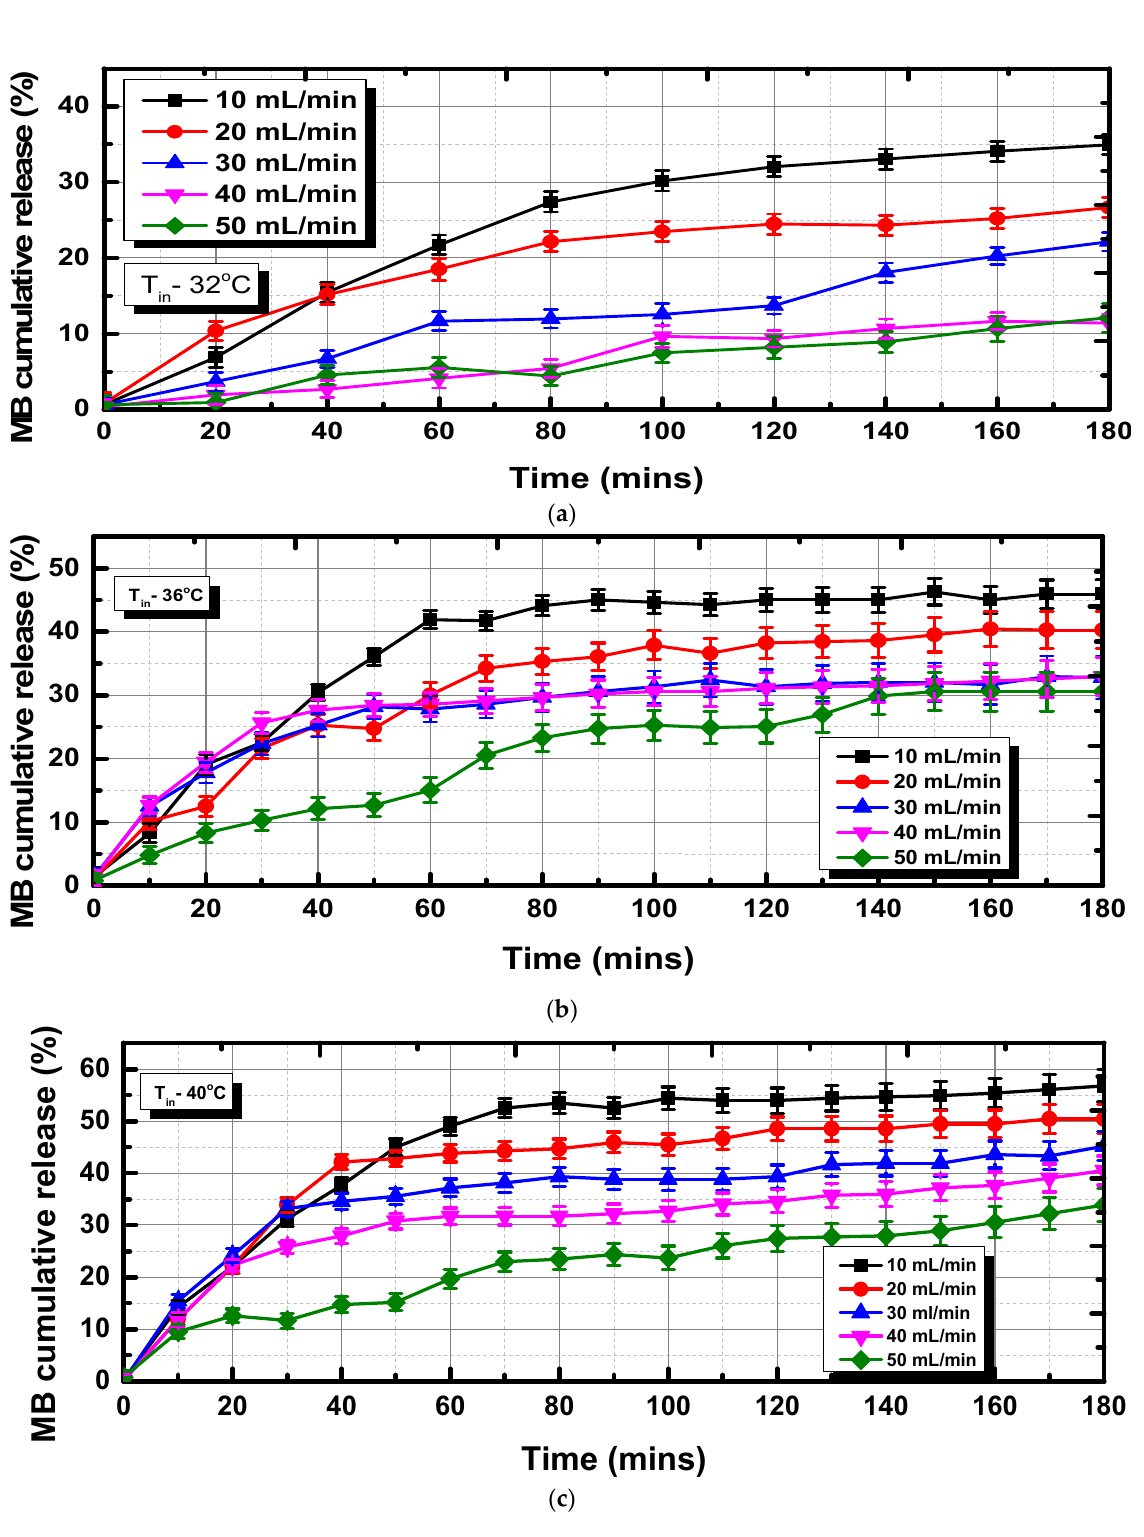
Figure 8. MB cumulative release as a function of time at di ff erent temperatures: ( a ) 32 °C, ( b ) 36 °C, and ( c ) 40 °C.